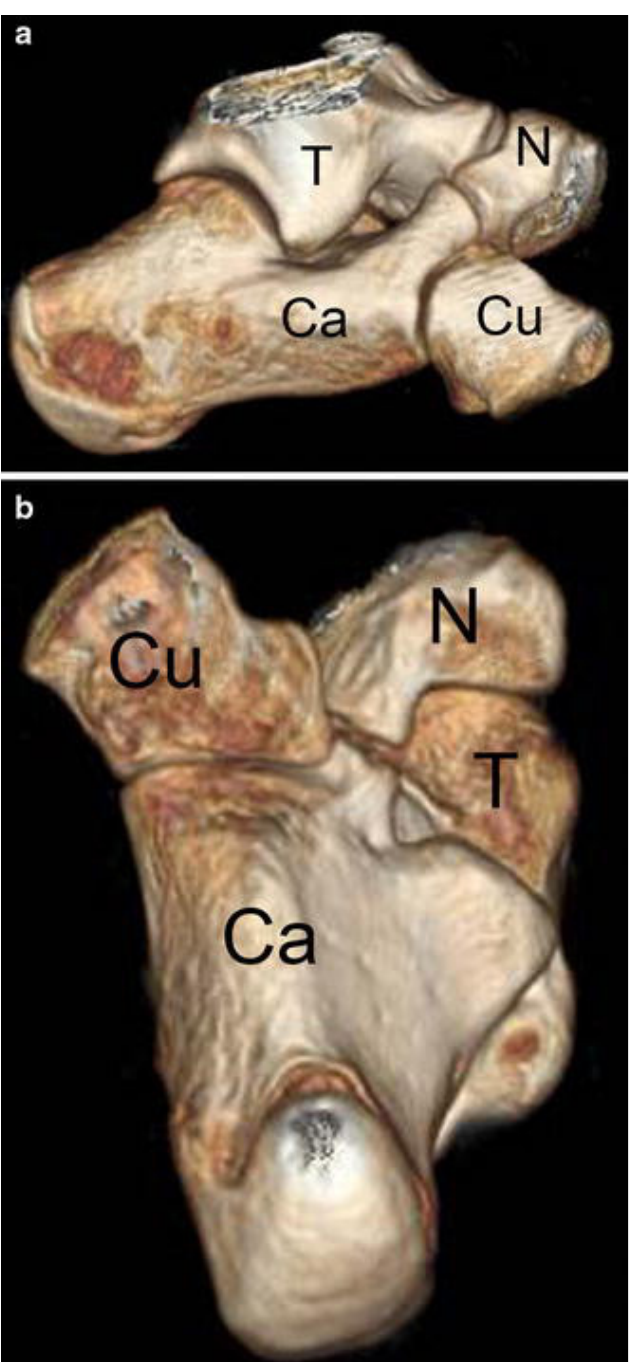
Figure 2. Cropped 3D reconstruction demonstrating sagittal ( a ) and axial ( b ) views of a calcaneona ‐ vicular coalition. (calcaneus (Ca), navicular (N), talus (T) and cuboid (Cu)) [11] (borrowed using Creative Commons licensing). Creative Commons